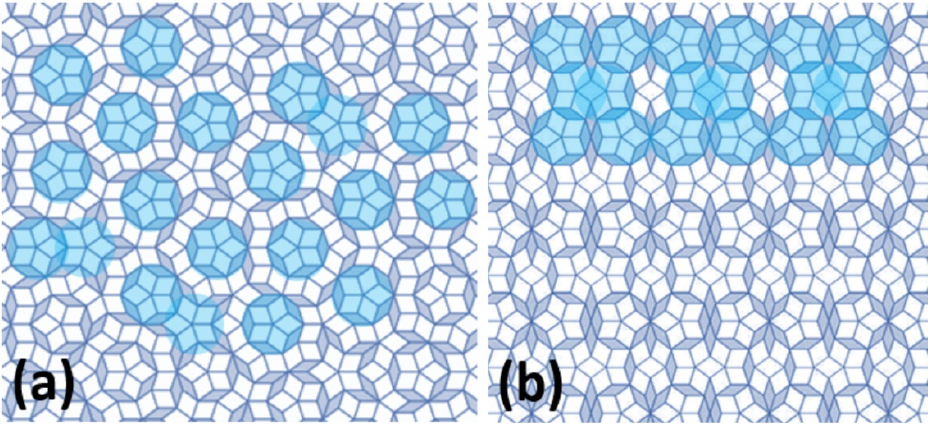
Figure 4. Schematic structure of quasicrystal ( a ) and quasicrystalline approximant ( b ) with denoted star-shape corresponding to clusters in real structure. Quasicrystalline arrangement is represented by Penrose tiling.